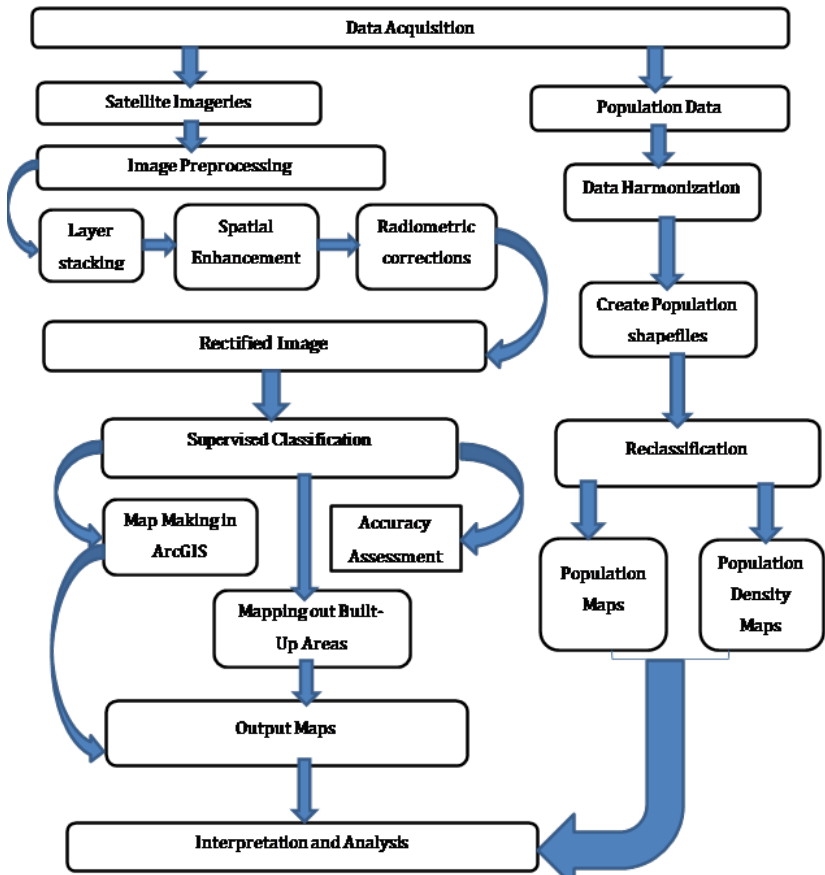
Fig. 2. Flowchart methodology summarizing the spatial analysis of urbanization using remote sensing and demographic